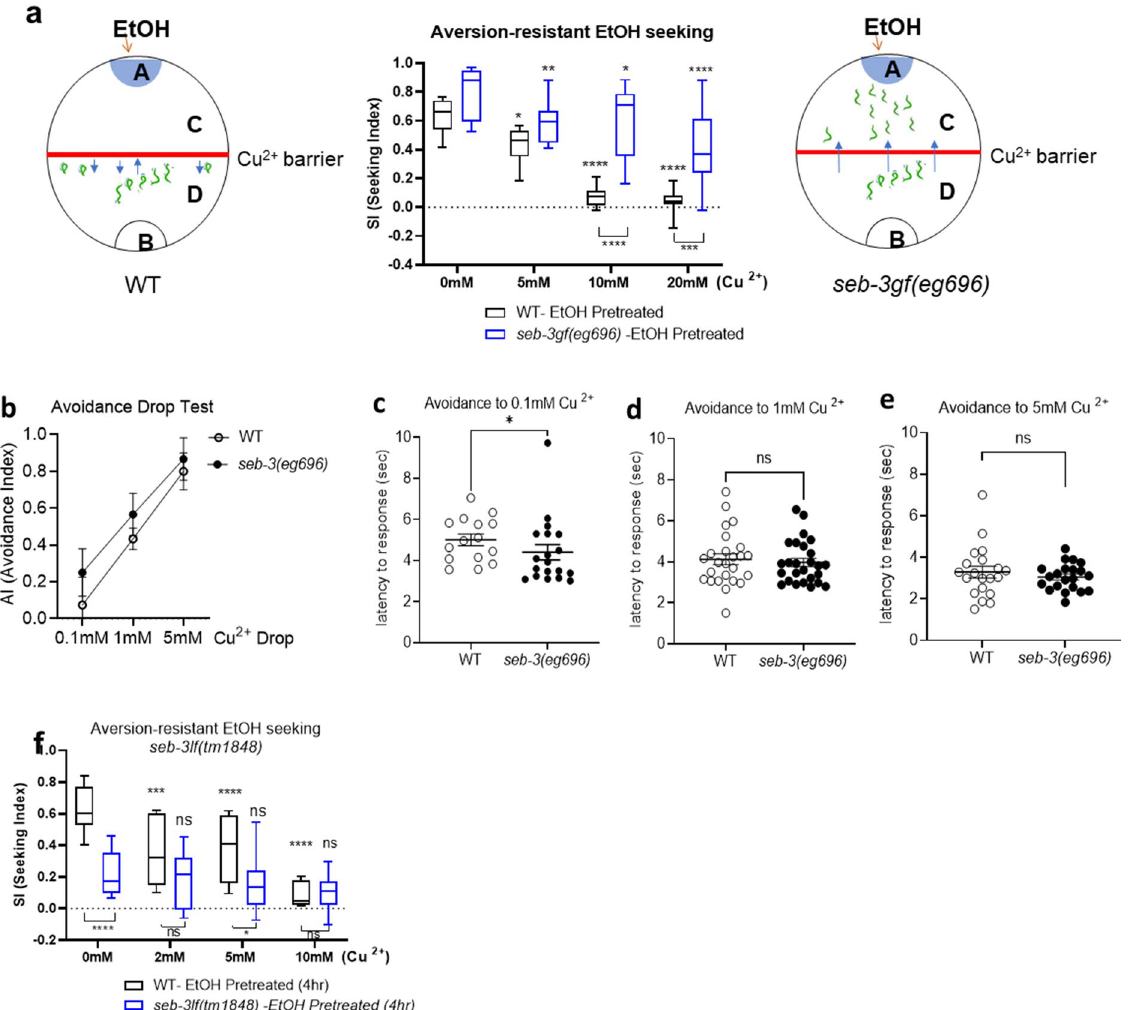
Figure 5. The ethanol pretreated seb-3gf animals for 4 h surmount a stronger aversive barrier to seek ethanol. ( a ) Strength of ethanol seeking is represented by the SI under different concentration of copper barrier (no barrier, 10 mM and 20 mM). A seb-3gf strain demonstrates more animals cross over the barrier for ethanol (aversion-resistant seeking), in overall concentrations, than does the WT strain [F Genotype (1, 18) = 35.78, p < 0.0001; F Concentration (3, 53) = 40.32, p < 0.0001; F Genotype×Concentration (3, 53) = 6.586, p < 0.001]. A two-way ANOVA comparison of the strains over concentrations of barrier showed significant differences based on genotype, concentrations, and the interaction of the two. Significant post hoc differences (Dunnett’s test) between no barrier versus 5 mM, 10 mM, or 20 mM in each genotype (WT and seb-3gf animals) is shown ( p < 0.05,*; p < 0.01,**; p < 0.0001, ****). Comparison between genotype is also shown ( p < 0.001,***; p < 0.0001, ****). Box and whisker represent minimum to maximum of 10 trials of population assay (N = 10). ( b – e ) Avoidance assay with drop test (0.1 mM, 1 mM, and 5 mM CuSO4). The avoidance index (AI) in ( b ) is the number of positive responses divided by the total number of trials. The latency to stop forward and initiate backward movement was measured. Data were obtained from 10 or more animals and mean values from 3 or more trials were analyzed by one-way ANOVA with a post-hoc Dunnett’s test; non-significant differences [ p = 0.0820, F genotypes (1, 7) = 4.117, p = 0.7705; F concentration×geneotype (2, 7) = 0.2707] ( b ) or two-tailed t-test; p < 0.05, * ( c – e ). ( f ) The development of aversion-resistant ethanol seeking is impaired in seb-3lf animals. A two-way ANOVA comparison [F Genotype (1, 17) = 24.64, p < 0.0001; F Concentration (3, 30) = 18.35, p < 0.0001; F Genotype×Concentration (3, 40) = 6.005, p = 0.0018]. Significant post hoc differences (Dunnett’s test) between no barrier versus 2 mM, 5 mM, or 10 mM in each genotype ( p < 0.001,***; p < 0.0001,****). Comparison between genotype is also shown ( p < 0.05,*; p <